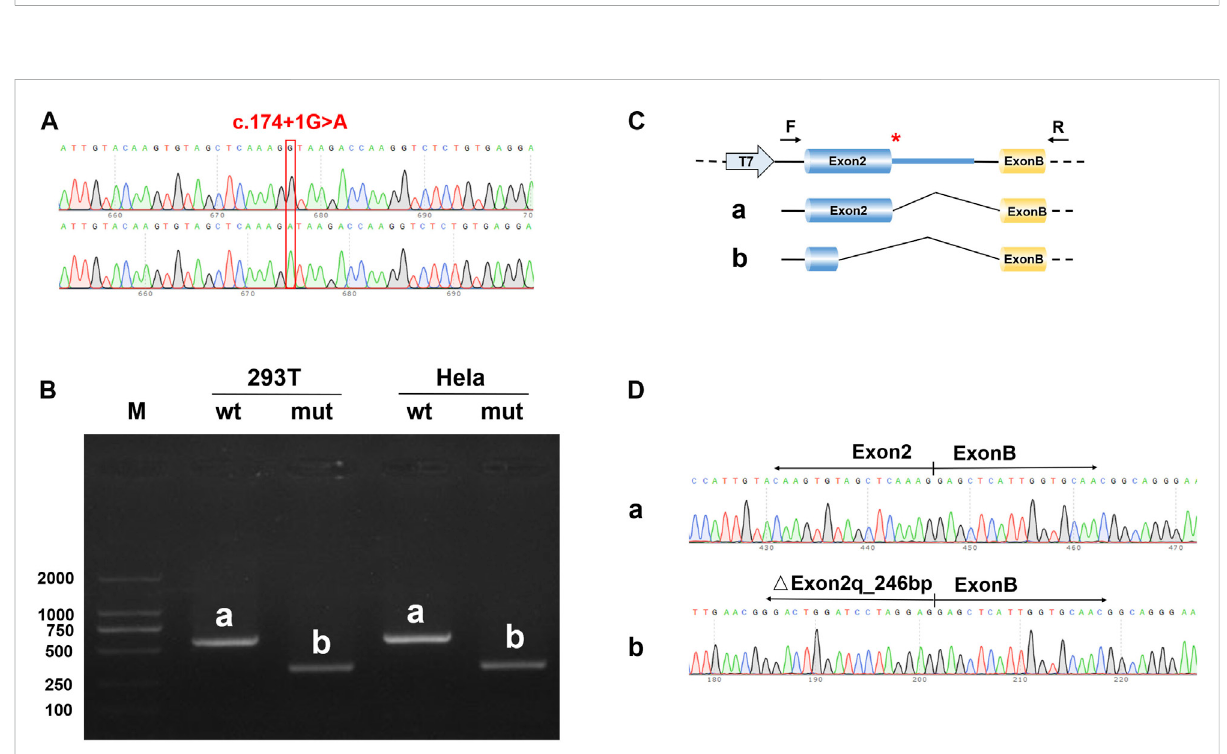
FIGURE 5 Results of the minigene splicing assay for NDP c.174 + 1G > A in HeLa and 293 T cells. (A) sequencing map of the minigene constructs, with the WT sequence at the top and the mutant sequence at the bottom. (B) electrophoretic map of RT-PCR transcription analysis.